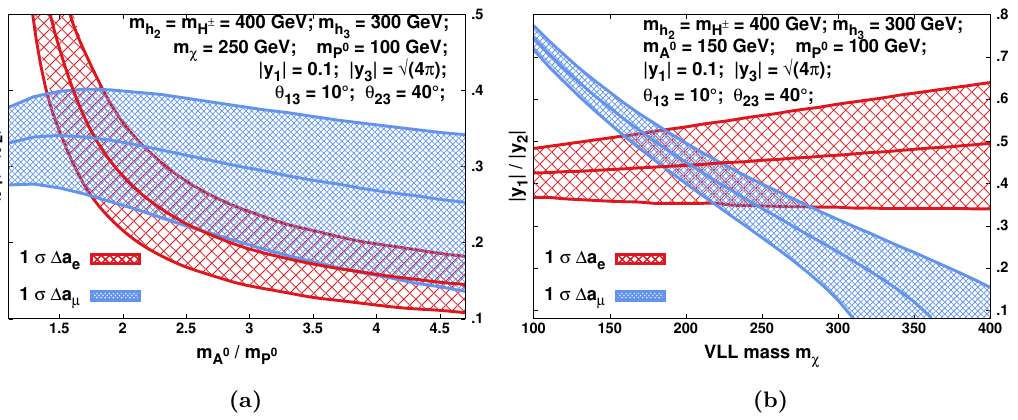
Figure 9. Colored solid contours and associated one sigma bands are shown in | y 1 | / | y 2 | − m / m and | y 1 | / | y 2 | − m χ planes satisfying ∆ a µ = (251 ± 59) × 10 − 11 [3] (in blue) and ∆ a e = A 0 P 0 [ − 88 ± 28 (expt . ) ± 23 ( α ) ± 2 (theory)] × 10 − 14 [11] (in red). Contours are drawn with fixed m χ = 250 GeV and m = 150 GeV in figures 9a and 9b respectively while other physical masses, A 0 couplings and angles remain same for the both. The overlap of the two bands depict the common parameter